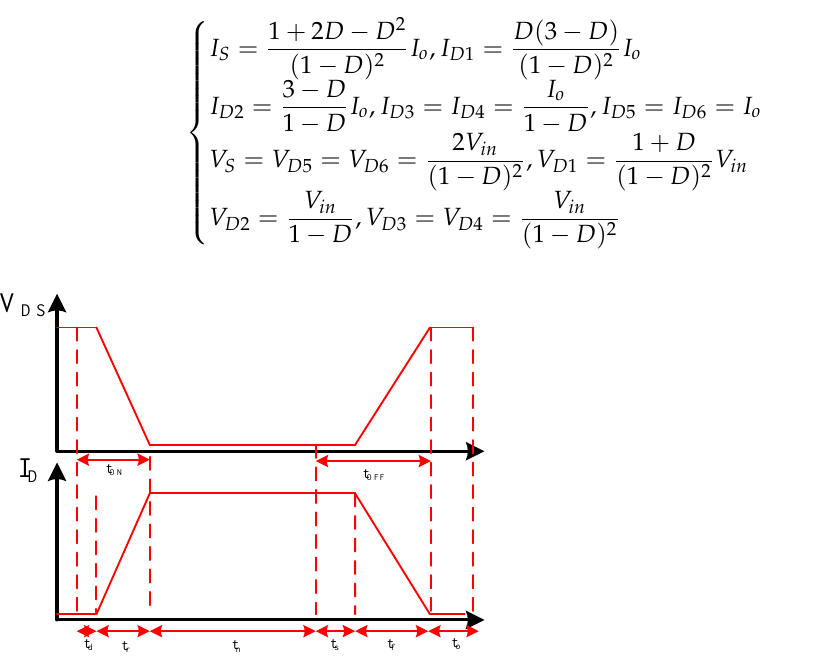
Figure 4. Drain current and drain-source